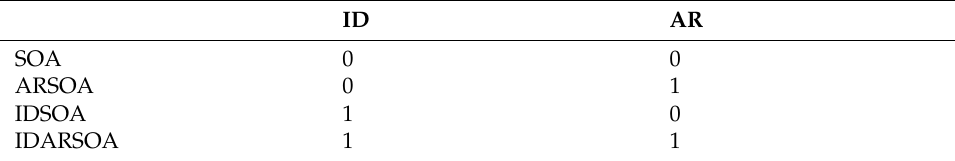
Table 4. The performance of the two strategies on SOA.